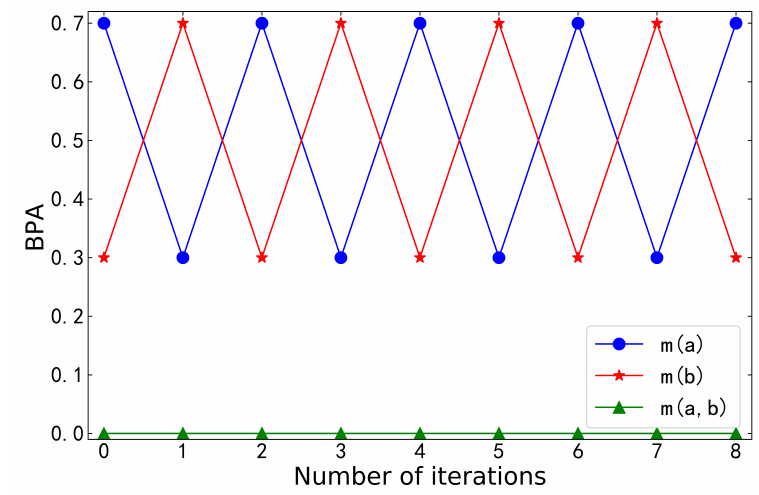
Figure 1. BPA after Yin’s negation iterations in Example 2.